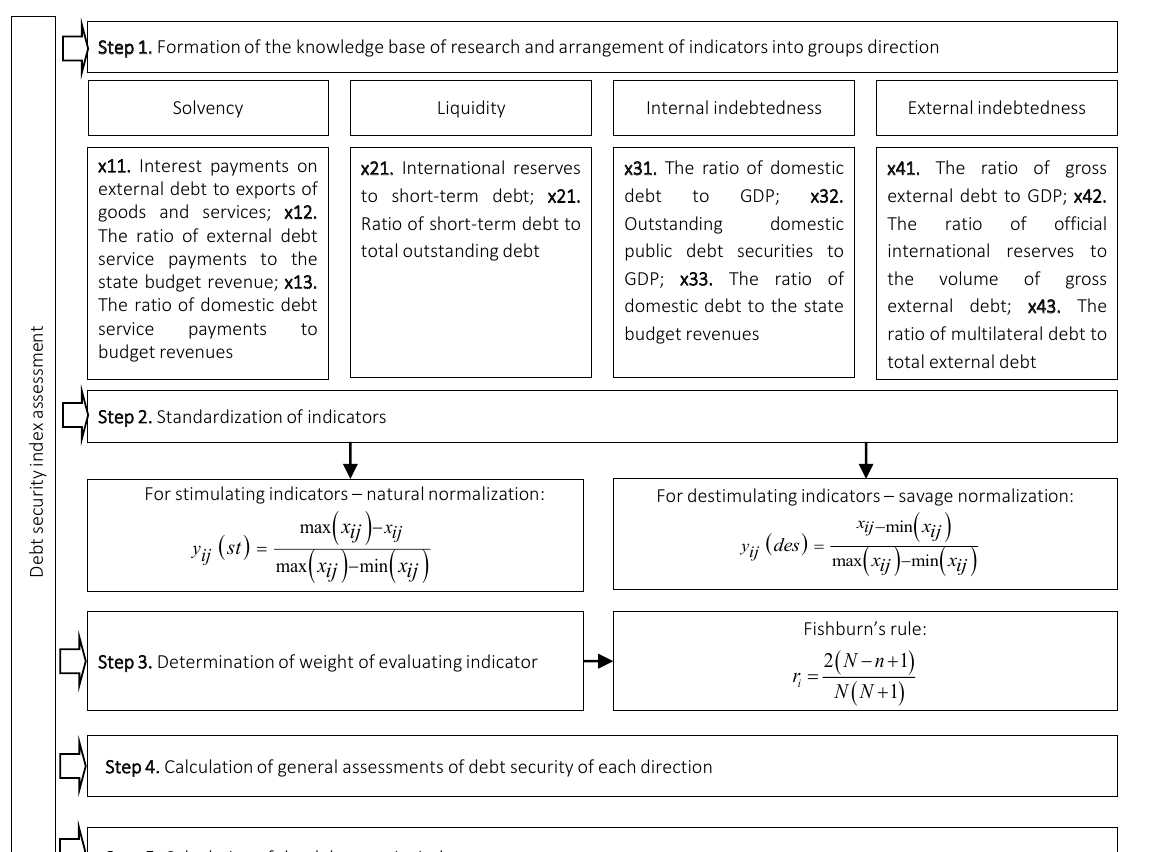
Figure 2. Conceptual framework for the assessment of the government debt security